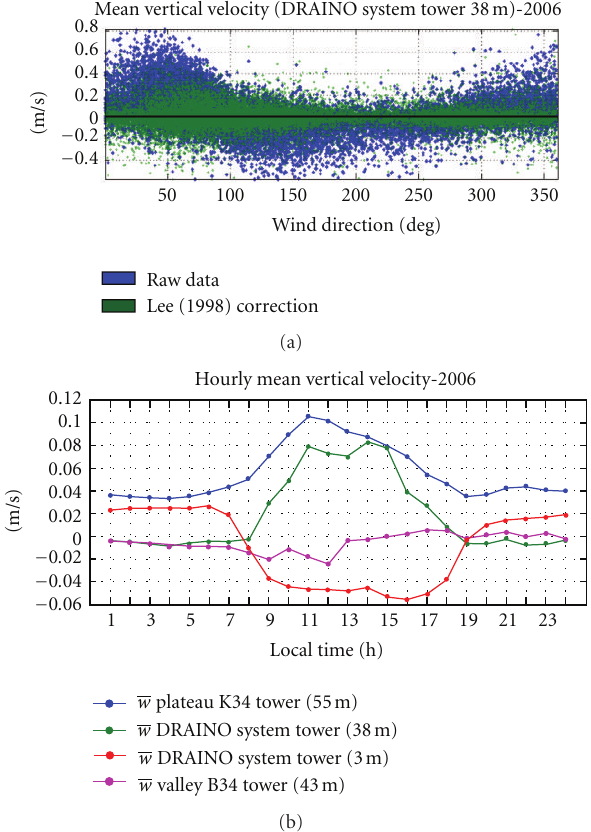
Figure 14: Mean vertical velocity raw and correct vertical velocity (a) for DRAINO system slope tower (38m), and hourly mean vertical velocity (b) for: plateau K34 tower (55m), DRAINO system slope tower (above canopy 38m and subcanopy 3m) and for valley B34 (43m) towers (see Figure 4, for